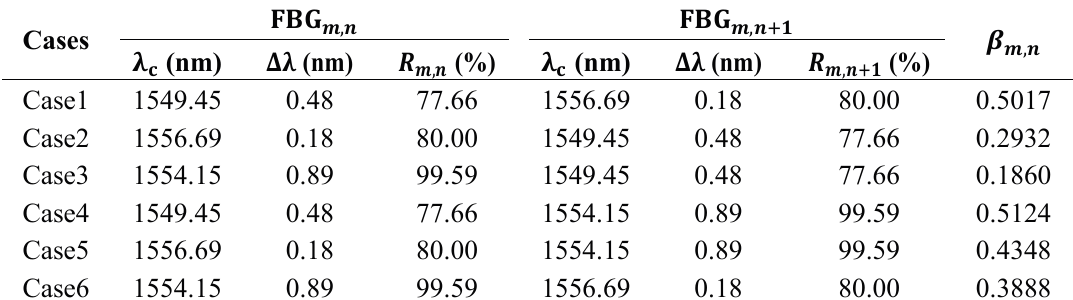
and FBG used in the experiments. (cid:3040),(cid:3041) (cid:3040),(cid:3041)(cid:2878)(cid:2869)